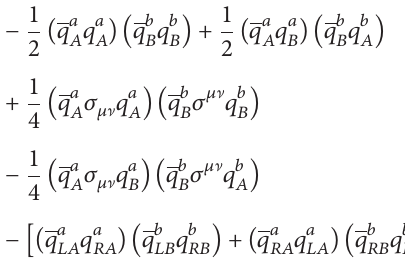
(500) , 𝜅(800) , and 𝑎 (800) ( 𝑓 (980) ), 0 0 0